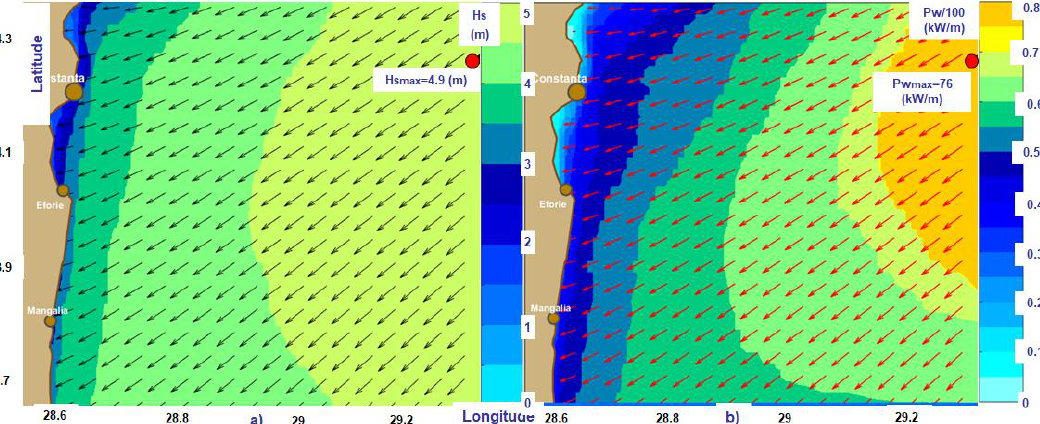
Figure 7. Average to high wave conditions in the southern side of the Romanian nearshore (computational domain Sph4—Southern RO1), model results corresponding to the time frame 7 October 2017. ( a ) Significant wave height scalar fields and wave vectors (represented by black arrows); ( b ) wave power scalar fields and energy transport vectors (represented by red arrows).